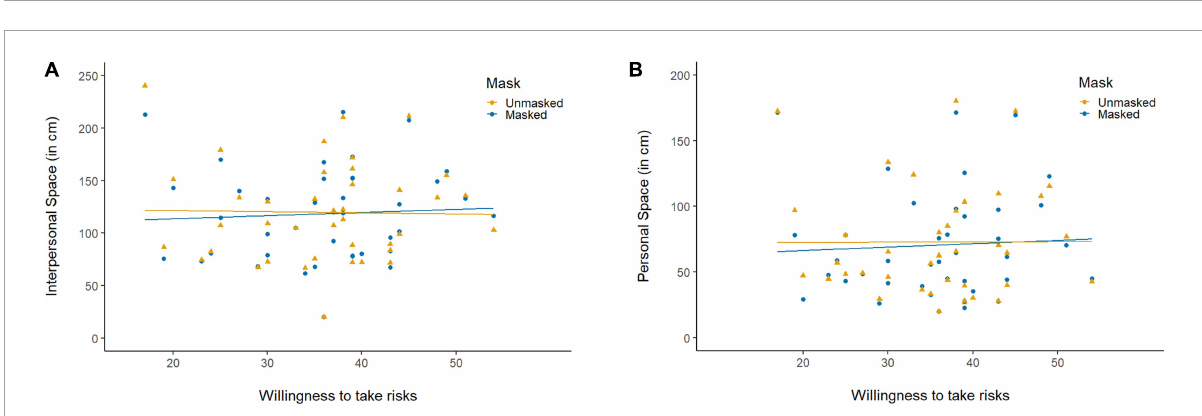
FIGURE3 The interaction between the effect of the face mask and the willingness to take risks on (A) interpersonal space (IPS) and (B) personal space (PS).